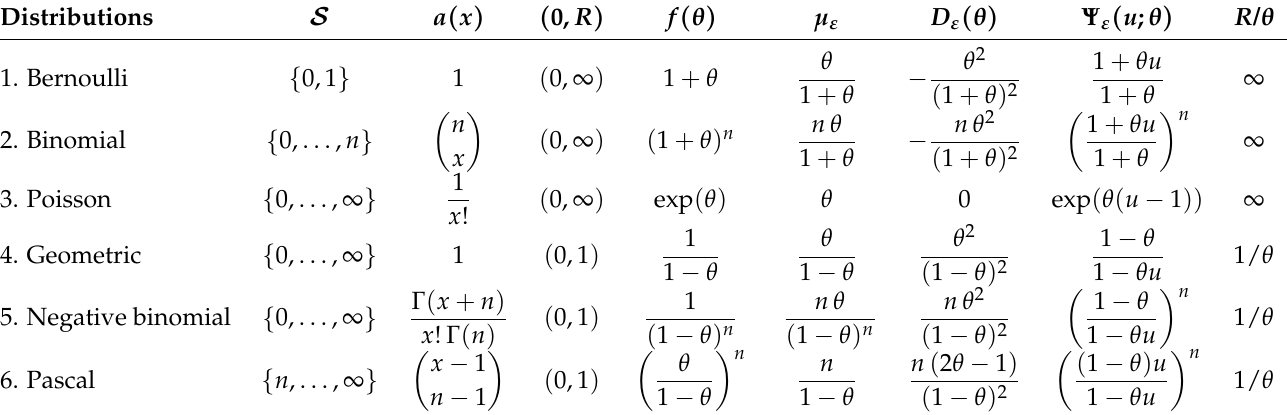
Table 1. Some specific PS distributions, along with their over-dispersion indices and